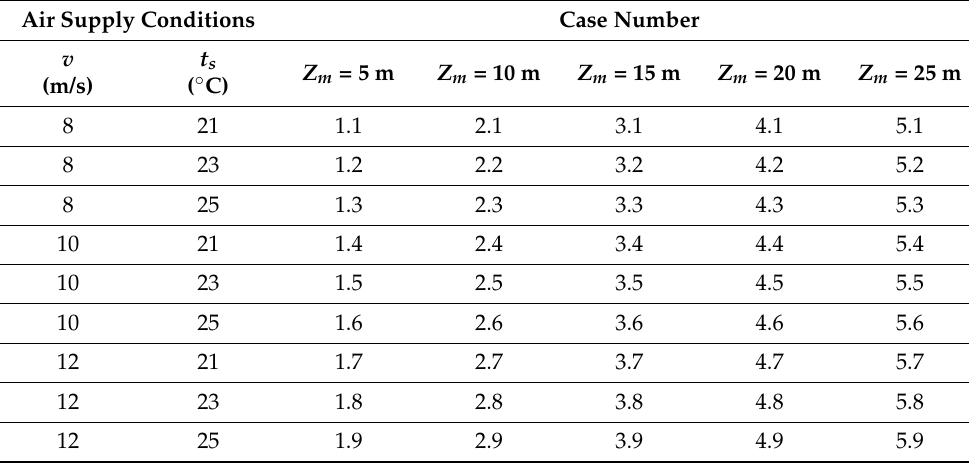
Table 6. Independent variables and the studied